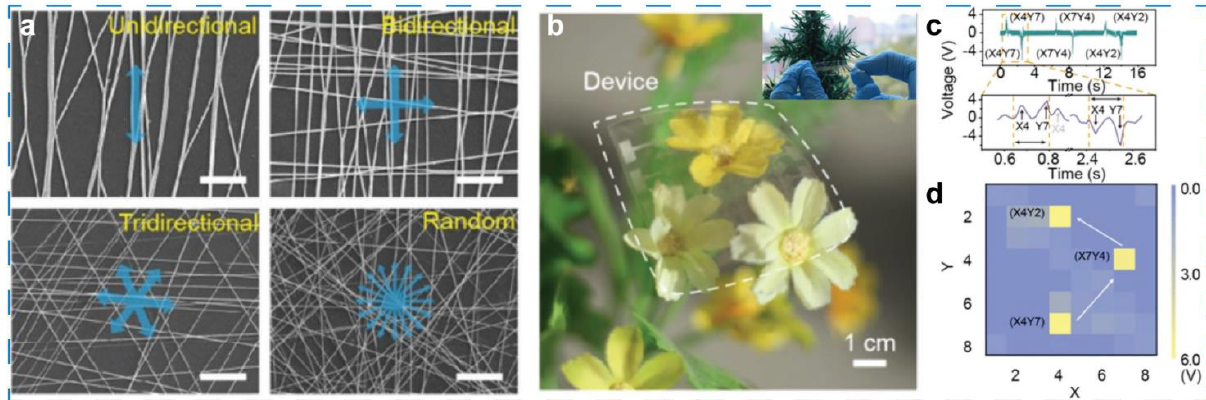
Figure 4. Highly stretchable and transparent Ag-nanofiber electrodes and self-powered sensor based on the electrodes. ( a ) SEM images of PVA nanofibers with different orientation. ( b ) Photograph of the 8 × 8 matrix that is made up of the self-powered triboelectric tactile sensor. The inset is a photograph of the electrodes. ( c , d ) Sensor signals when the finger tough the pixel sequentially in the sensor and the corresponding mapping image, respectively. Reproduced with permission. [54] Copyright 2018, Wiley − VCH.